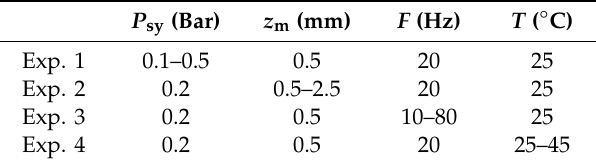
Table 2. The setup parameters for the four